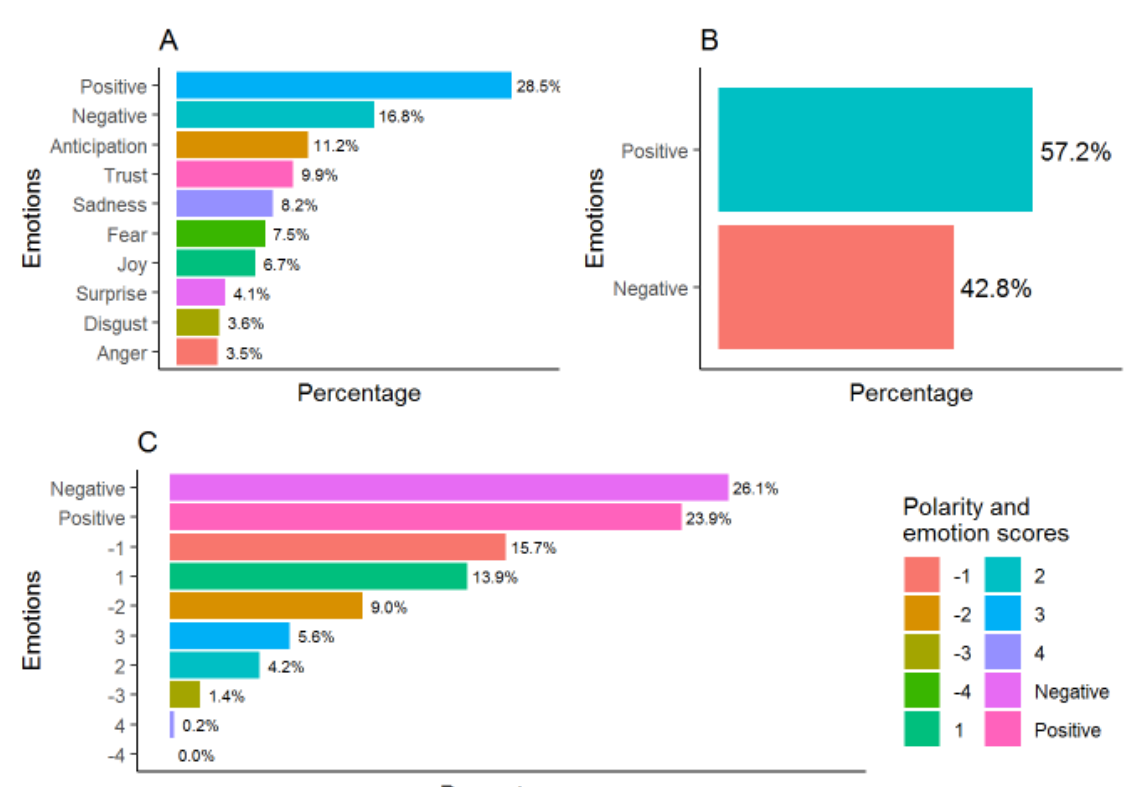
Figure 3. Emotion scores analysed according to National Research Council Canada/NRC ( A ), Bing ( B ), and Afinn ( C ) dictionaries .